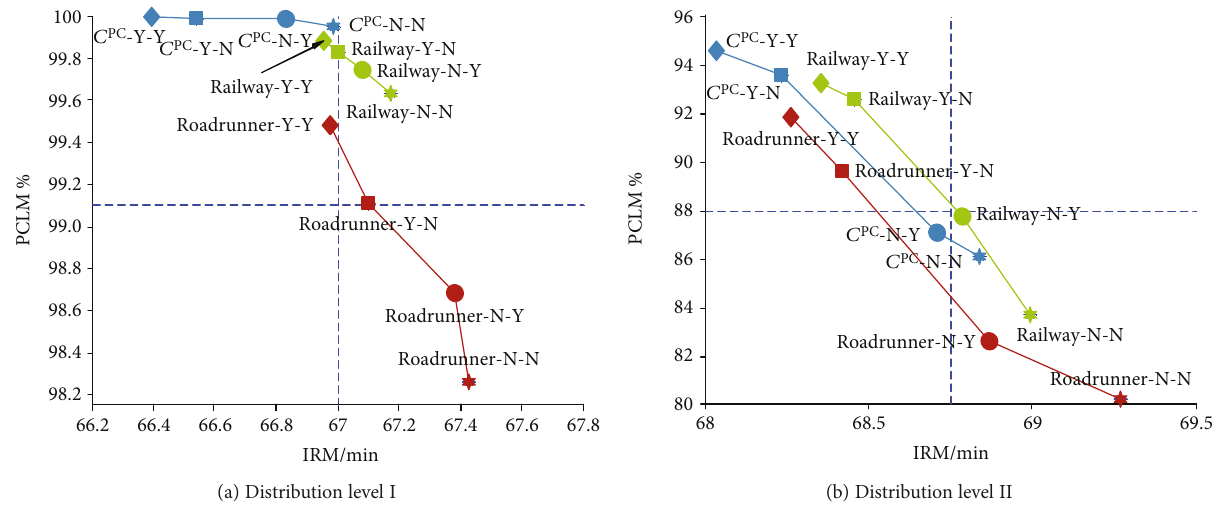
Figure 13: Results of resource allocation scheme combinations and scheduling policies under mission case